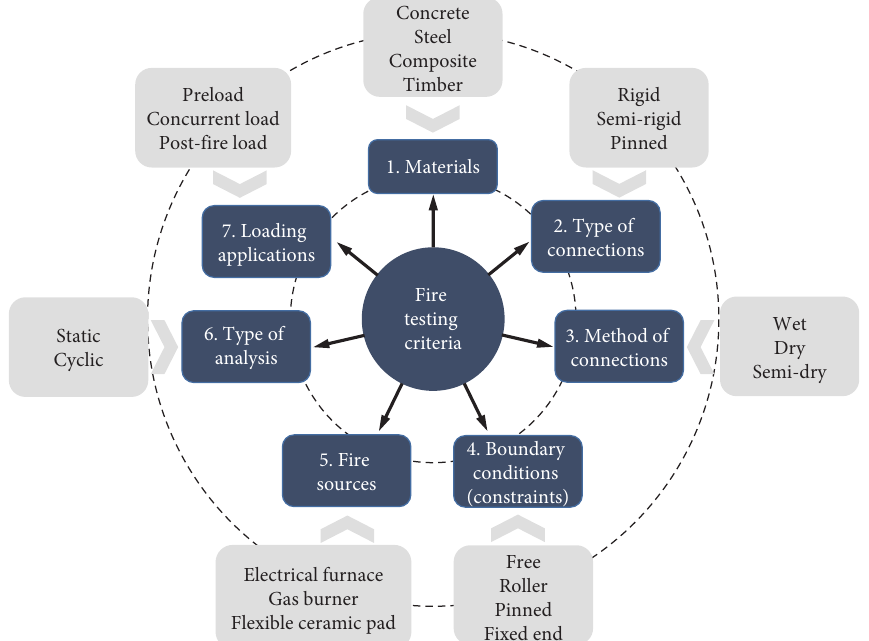
Figure 4: The fire testing criteria for beam-to-column